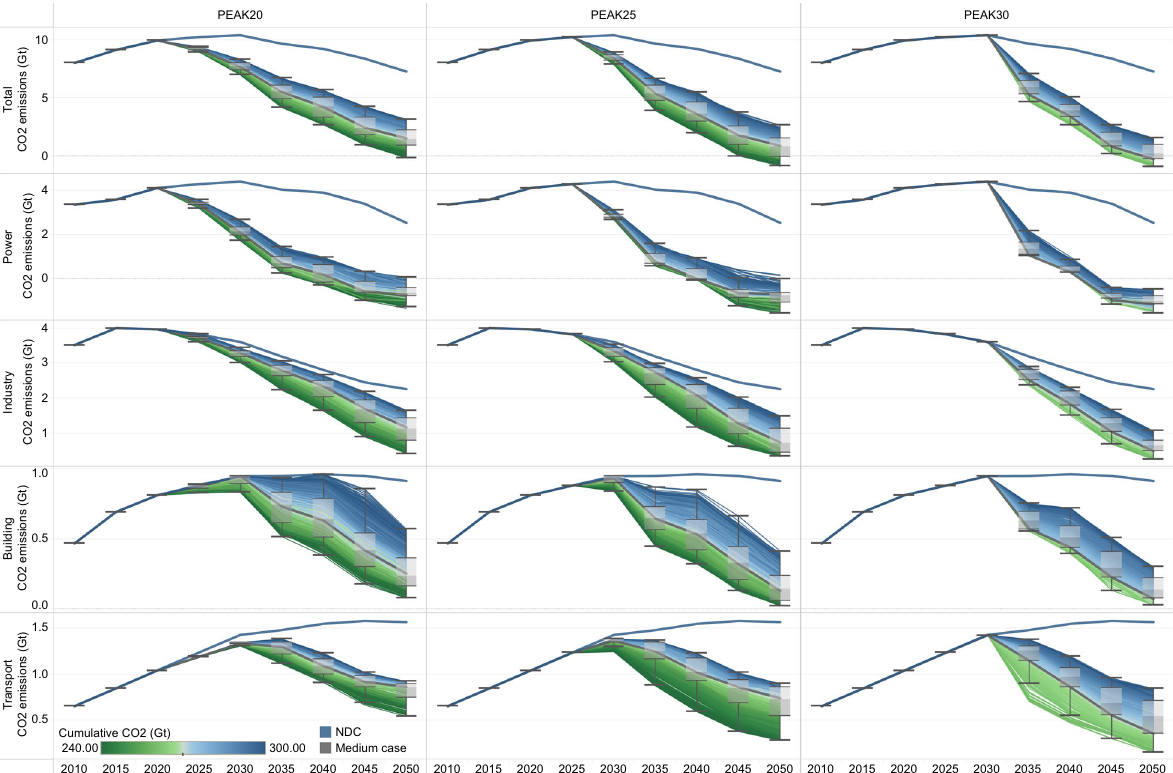
Fig. 2 Sectoral energy-related CO 2 emission pathways under broad cumulative carbon budget range under different scenarios (unit: GtCO 2 ). The box plot shows the fi rst quantile, intermediate range (IQR), and third quantile of all the results, where the data range within 1.5 times the IQR is denoted with whiskers. The thick blue line represents the emission pathway of the NDC scenario, and the thick gray line represents the emission pathway for the intermediate case in each scenario. The divergent color from blue to green re fl ects the increasing stringency of the cumulative carbon budget. The cumulative CO 2 parameter corresponds to the absolute value of China ’ s cumulative carbon budget for 2010 –